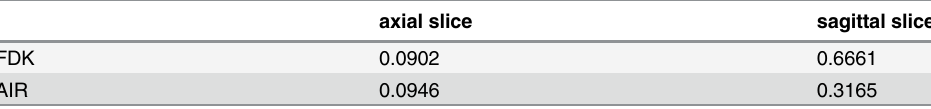
Table 1. The normalized root mean square error in Fig.